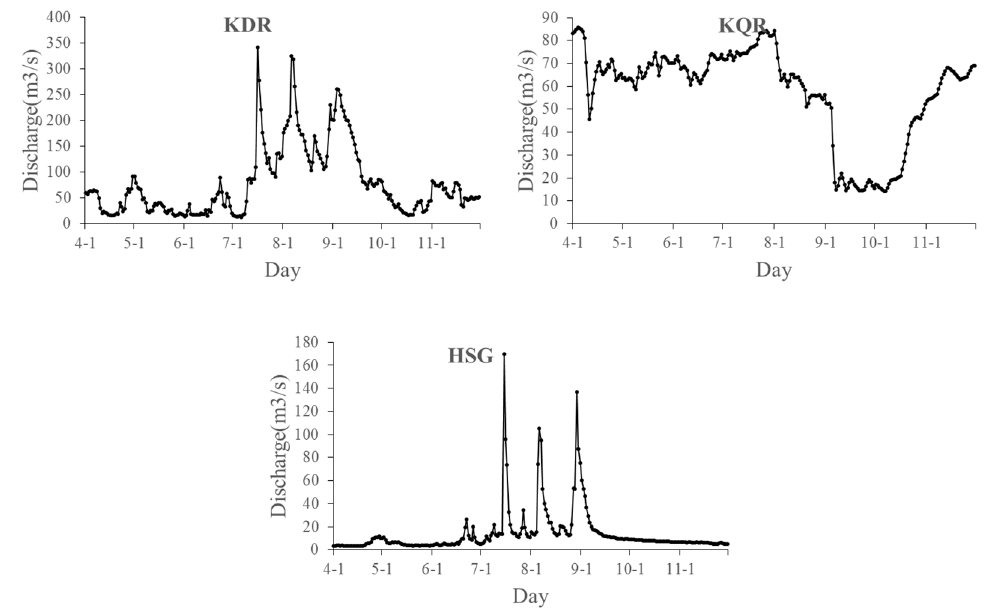
Figure 4. The flow at hydrological stations of Kaidu River (KDR), Huangshuigou (HSG), and Kongque River (KQR) used in driving the model of Bosten Lake during the study period from 00:00 1 April to 00:00 30 November 2005.